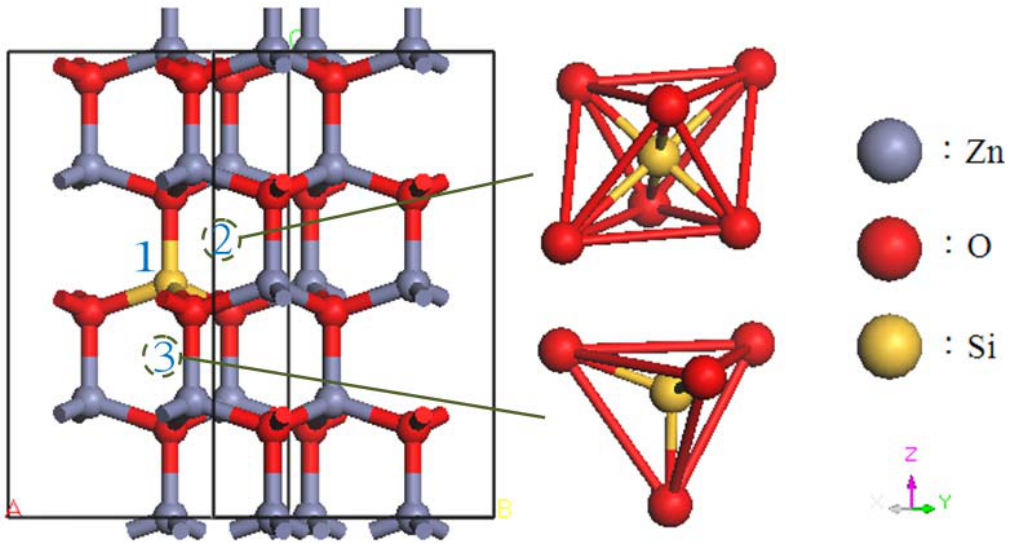
Figure 1. A 2 × 2 × 2 ZnO supercell model containing substitutional and interstitial Si atoms. Gray, red, and yellow spheres represent Zn, O, and Si atoms,